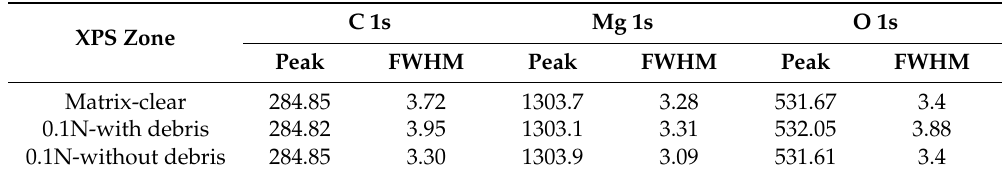
Table 1. Binding energies and full-width-at-half-maximum (FWHM) of C 1s, Mg 1s, and O 1s peaks before and after sliding friction